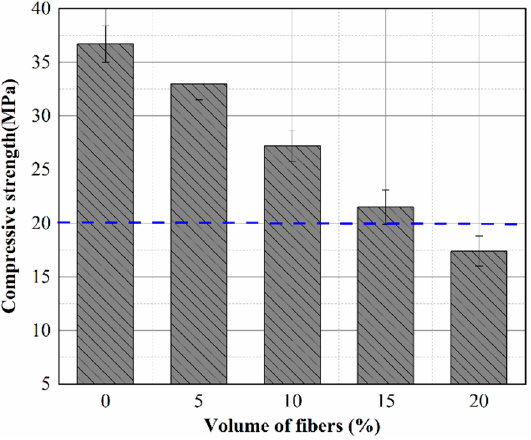
Figure 5. Effect of fiber content on the strength of thermal-insulating concrete.